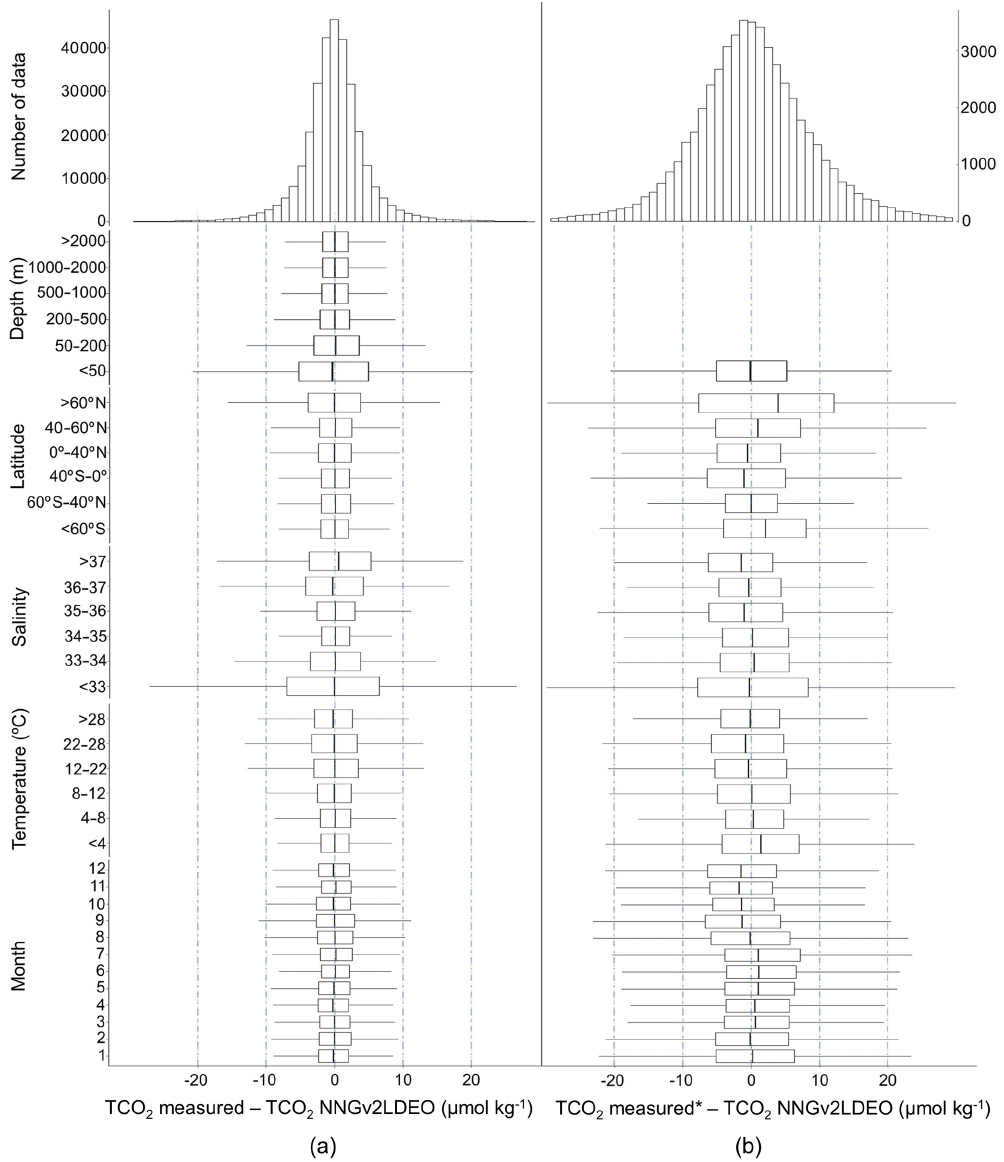
Figure 4. Histograms and box plots of differences between measured and neural-network-computed TCO 2 in (a) Gv2 and (b) LDEO. ∗ TCO 2 computed from measured p CO 2 and neural-network-derived A T